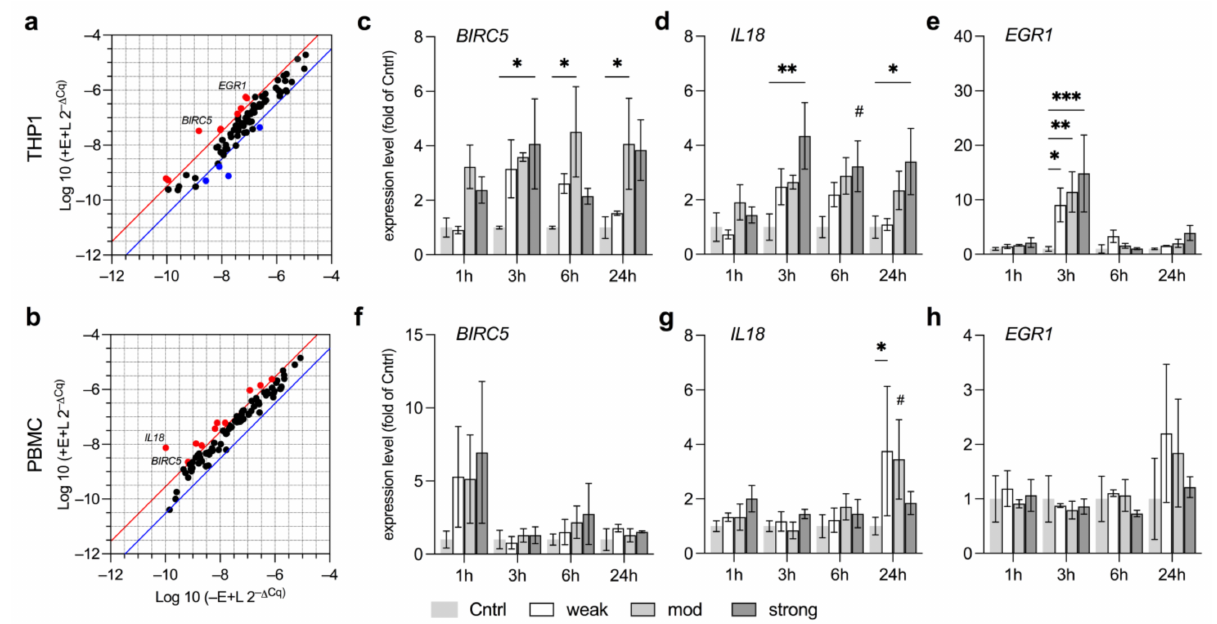
Figure 6. PrimePCR and target expression analysis of key immune regulatory genes following exposure to EMF at different field strengths. ( a , b ) Prime PCR of immune disease related targets probing THP1 ( a ) and PBMC ( b ) after exposure to stEMF for 3 h. Genes were considered as upregulated (red) or downregulated (blue) if deregulated more than 4-fold compared to the LPS-stimulated and non-exposed control. The key hits BIRC5 , IL18 and EGR1 (indicated by name) that are elevated in the PrimePCR of either THP1 ( c – e ) and/or PBMC ( f – h ) were tested at different time points and field strengths ( N = 3, n = 2). Data are given as fold of Cntrl (mean ± SEM). * p < 0.05, ** p < 0.01 and *** p < 0.001 as indicated. # p < 0.08 representing a